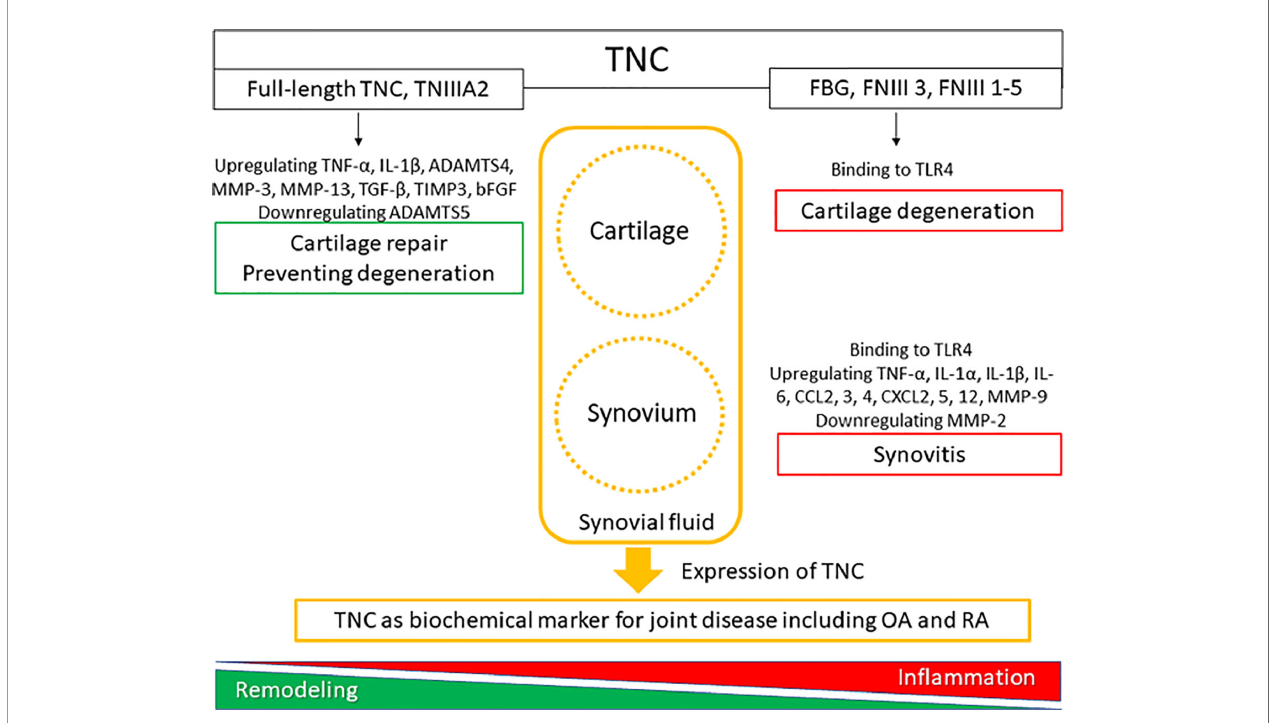
FIGURE 1 | The roles of tenascin-C (TNC) in synovial joint biology. TNC expression is upregulated in degenerated cartilage and in fl amed synovial